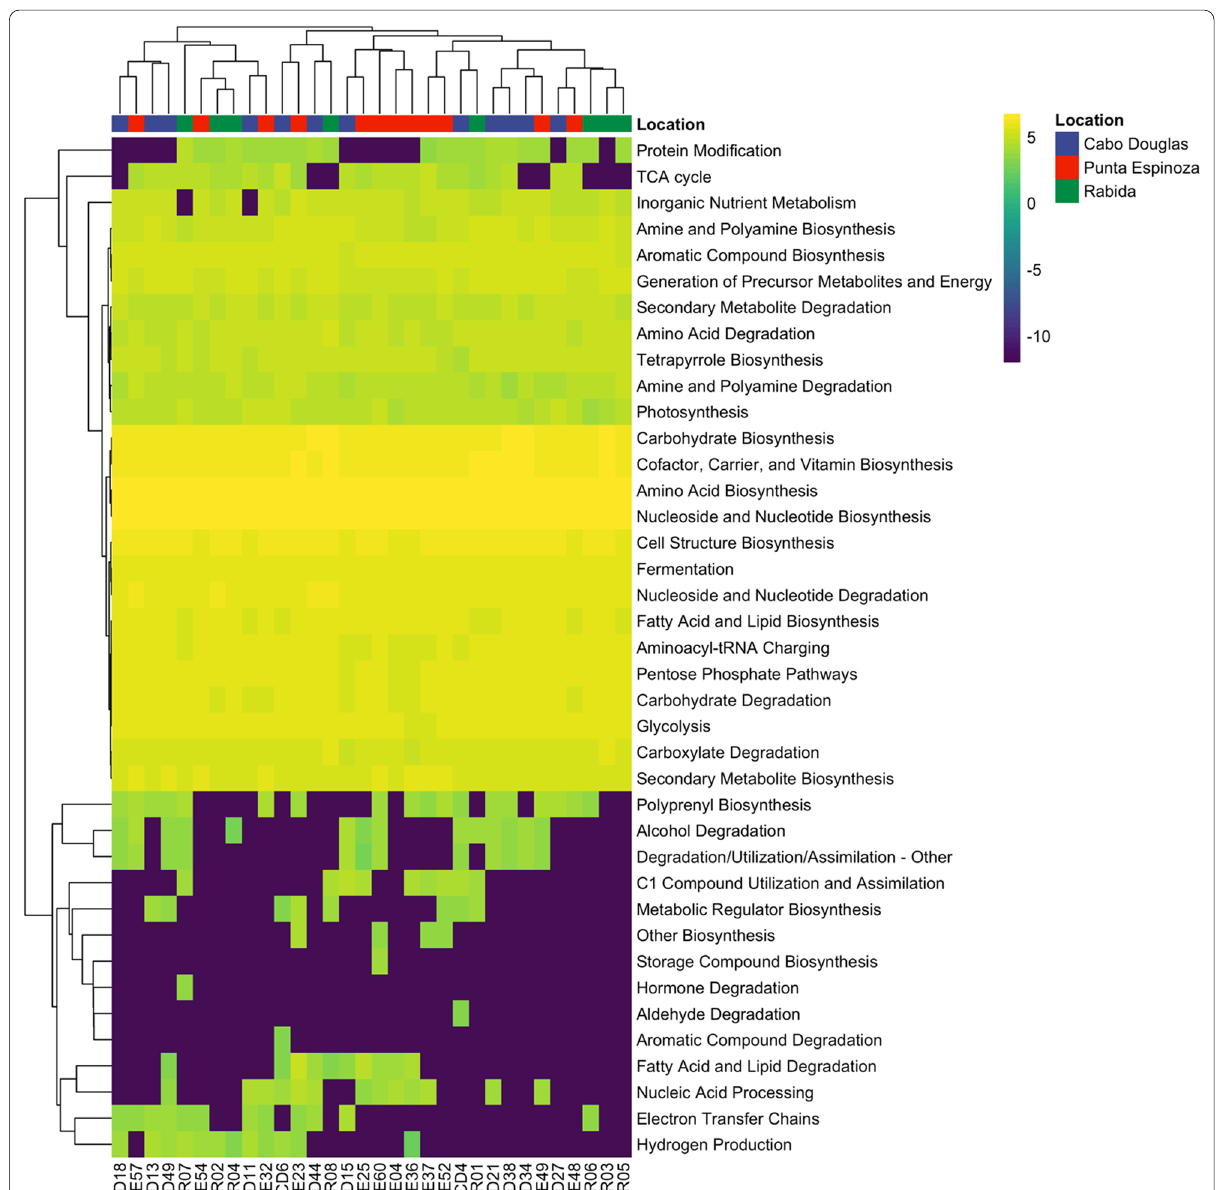
Fig. 4 Heatmap of the functional gut microbiome profile of the Galapagos marine iguanas. The abundance of each pathway subclass is shown as the logarithm 10 of the proportion of reads. Hierarchical clustering with the method Ward was used to aggregate samples and metabolic